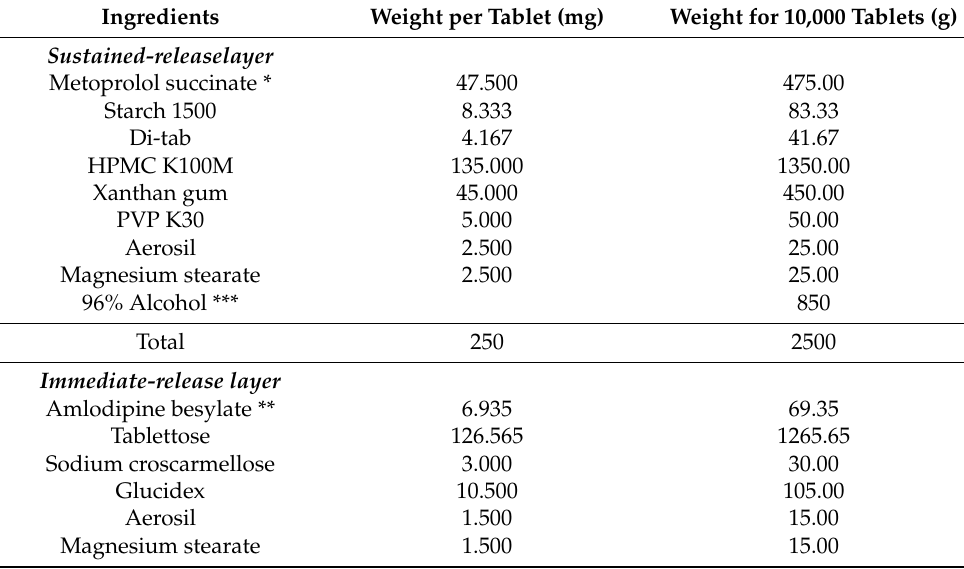
Table 1. Formula for film coated bi-layer